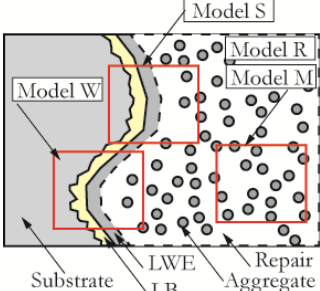
Figure 3: Three models for FEM